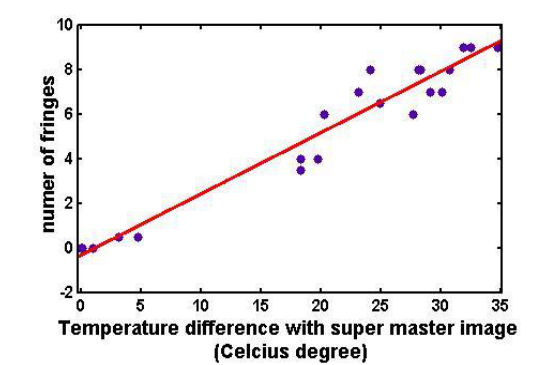
Figure 5. correlation between temperature and number of